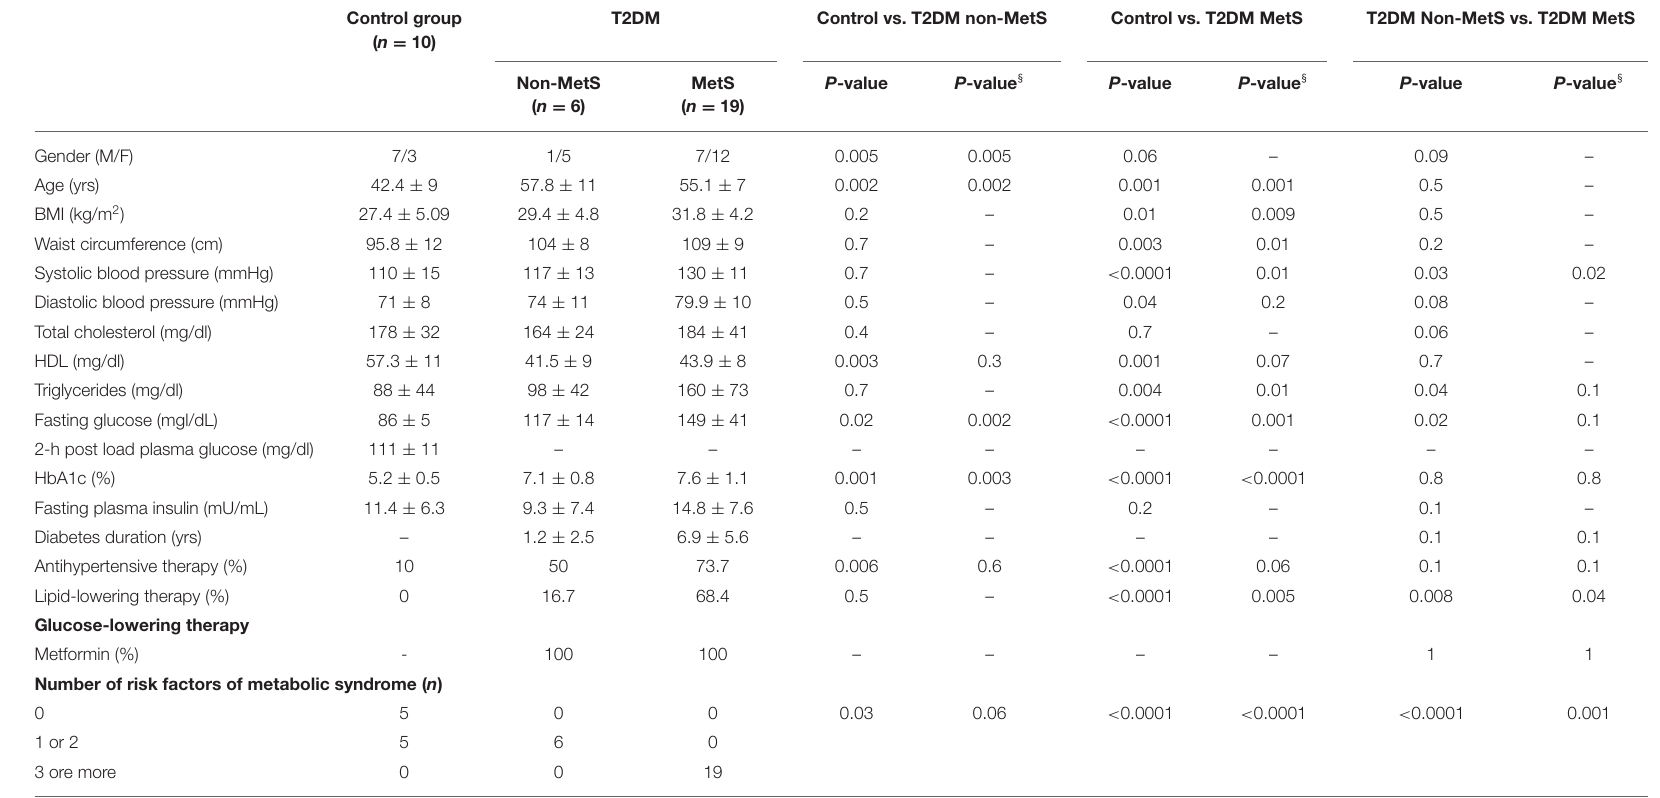
TABLE 1 | Differences in clinical characteristics of subjects with T2DM according to metabolic syndrome compared to control